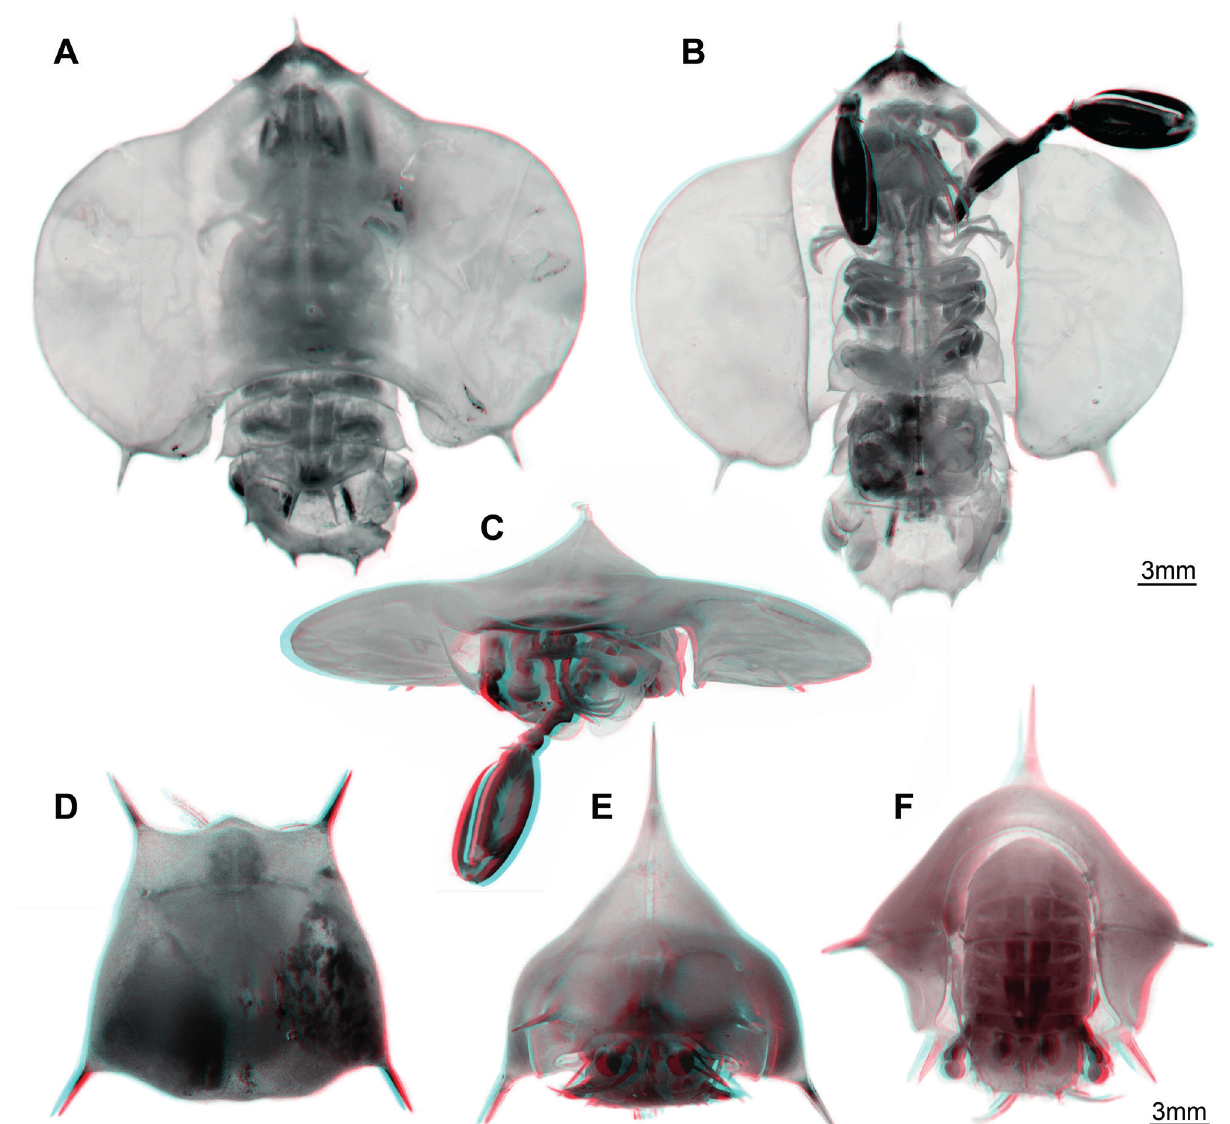
Figure 6. Red-cyan stereo-anaglyph images of the “flying saucer” and the “gnome hat”. A-C. “Flying saucer”; ZMUC-CRU-8666. A. Dorsal view. B. Ventral view. C. Anterior view. D–F. “Gnome hat”; ZMUC-CRU-8661. D. Dorsal view. E. Anterior view. F. Posterior